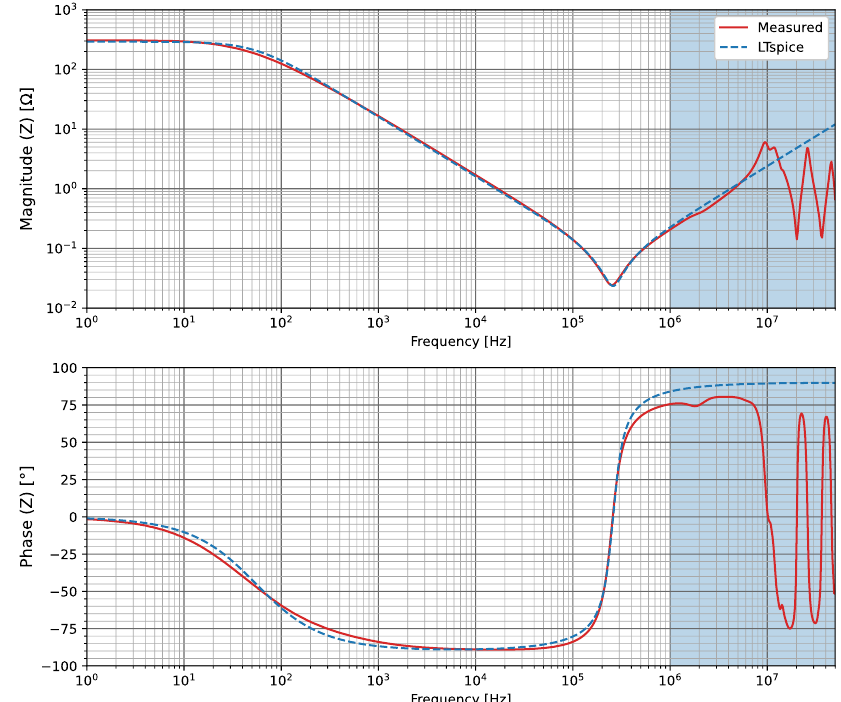
Figure 24. Large PV module measured (one-port) and simulated per-cell impedance curves (frequency range 1Hz to 50MHz).